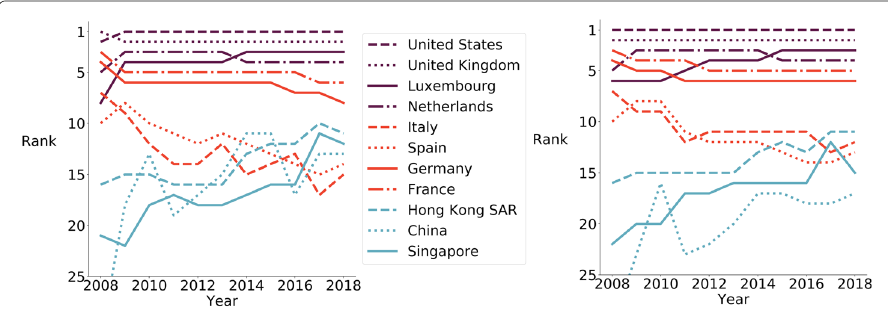
Fig. 3 Results of computing MultiRank on the multiplex global financial network versus computing PageRank on the aggregate financial network. We show the temporal evolution of (left) MultiRank and (right) PageRank for several countries. We show the dominant financial countries in purple, mainland European countries in reddish orange, and Asian countries in blue In Fig. 2, we show a visualization of the multiplex global financial network for